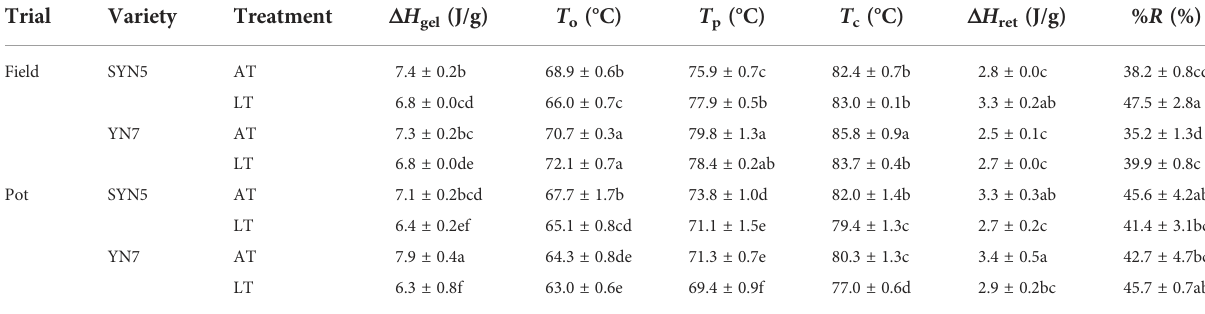
TABLE 2 Effects of post-silking low temperature on fl our thermal properties of waxy maize.